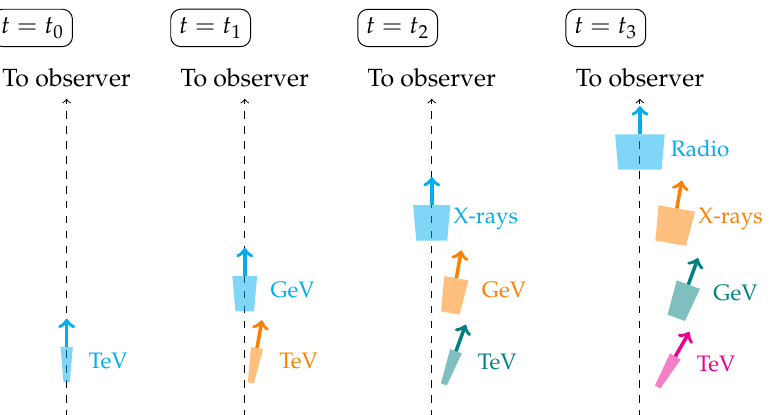
Figure 3. Sketch of the precessing jet scenario in the multi-wavelengths context. The figures appear in chronological order from left to right, each representing an epoch during which a new ejection of plasma occurs. Each ejection is marked with a different color and propagates, as indicated by the colored arrows, in a different direction with respect to the line of sight as time evolves. Expansion of the plasma is represented by the ejections becoming broader, following a conical shape, as they propagate. The energy regime of the emission from each ejection is labelled right to it in the same